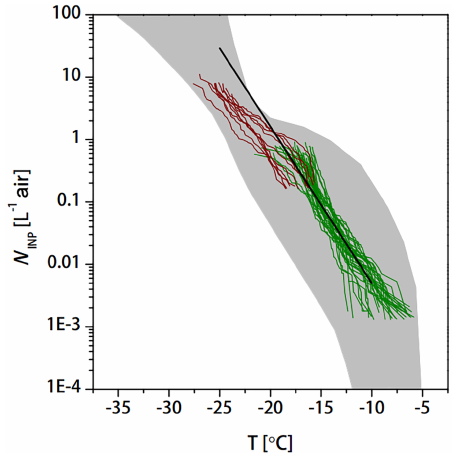
Figure 8. N INP as derived from precipitation samples collected in Petters and Wright (2015) (grey area) and a parameterization based on Fletcher (1962) (black line), together with our results (dark green and brownish lines from INDA and LINA measurements, respec- tively).